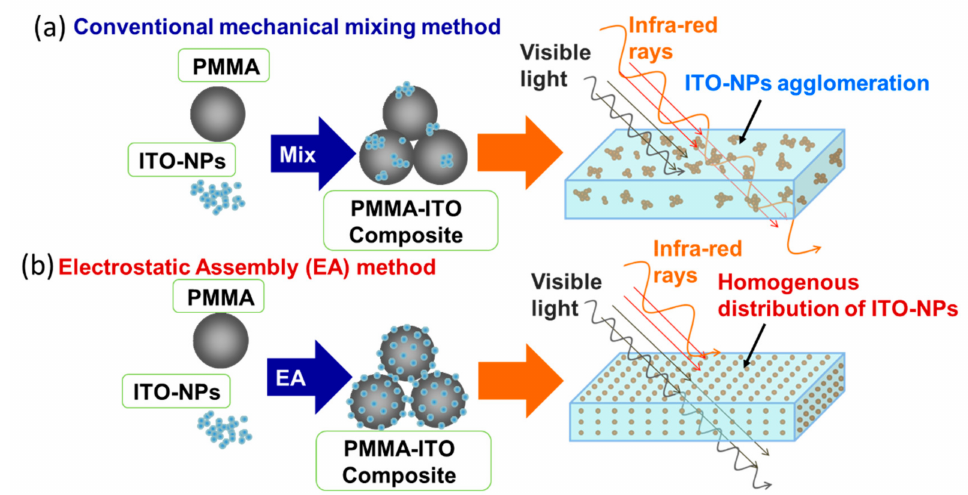
Figure 7. Illustration showing the comparison of the PMMA-ITO composite particles and pellets fabricated using ( a ) conventional mechanical mixing method and ( b ) electrostatic assembly method as well as its corresponding light transmission characteristics in the visible and IR